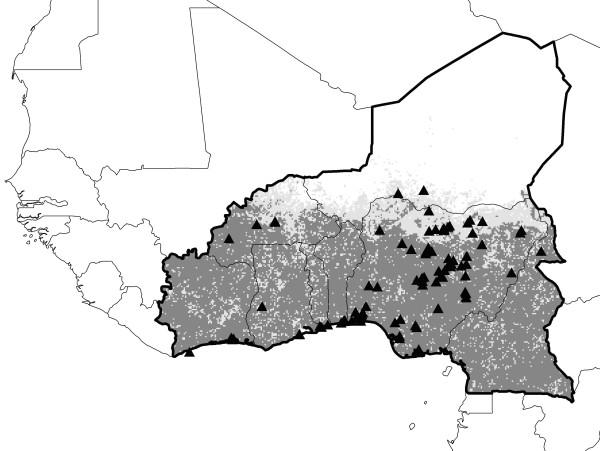
Regional projection across West Africa of HPAI-H5N1 ecological niche model. Results based on OIE case occurrence points and environmental layers for the Middle East and northeastern Africa. Model predictions are shown as ramps of model agreement in predictions: light grey = 5–9 models predict potential presence, dark grey = all models agree in predicting potential presence. Black diamonds indicate independent test data (N = 101) from the region [10,11]. Study area is delineated by bold border.